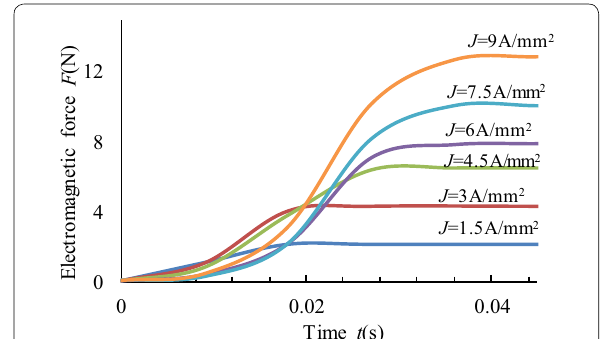
Figure 17 Output force rising time curve of the outer rod